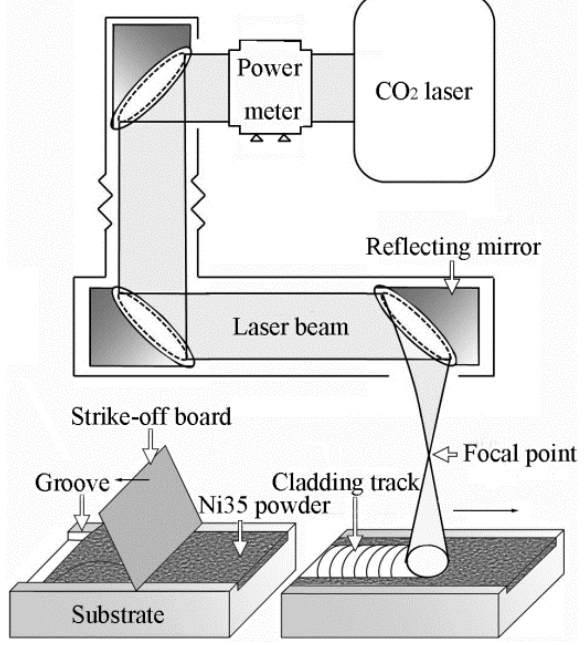
Figure 1. Schematic illustration of the preplacing method and laser cladding process.